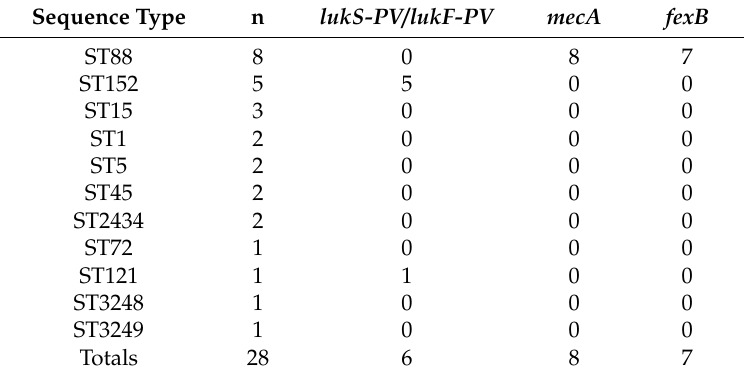
Table 1. Sequence types and associated virulence and resistance